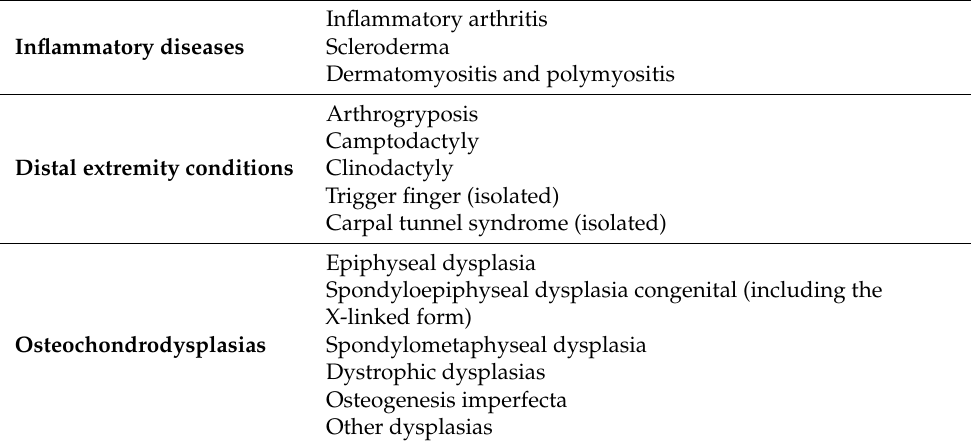
Table 3. Differential diagnosis of musculoskeletal manifestations in